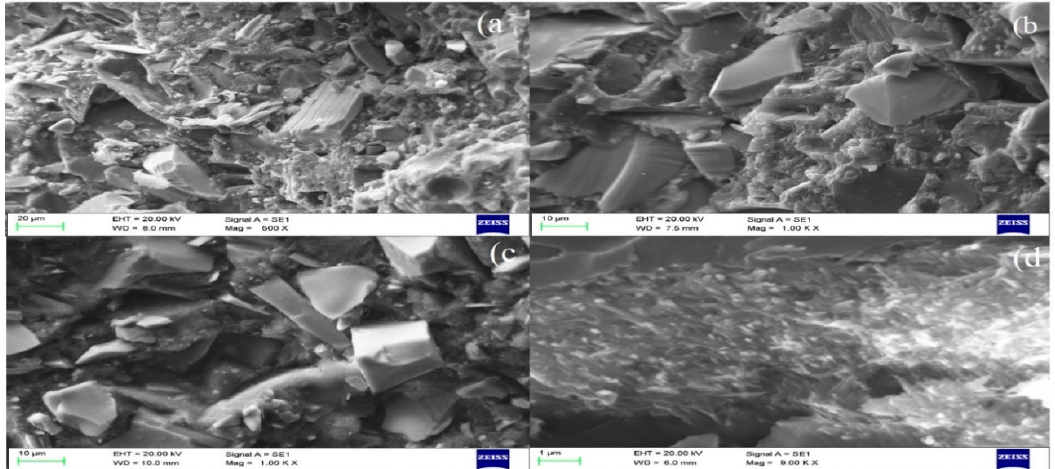
Figure 7. SEM images displaying the fractured surfaces of glass-filler-comprising composite specimen: control group (composite without HNT/CHX fillers) ( a ), composite with 2.5 wt.% HNT/CHX ( b ), composite with 5 wt.% HNT/CHX ( c ) and composite with 10 wt.% HNT/CHX focused on the Halloysite agglomerates ( d ).